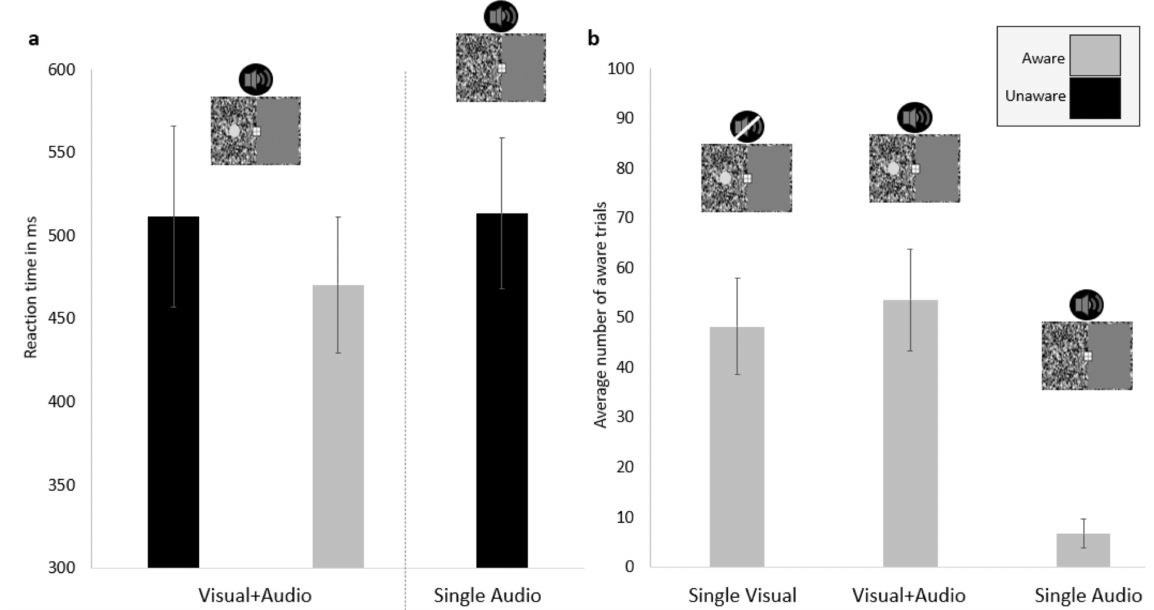
Figure 3. Reaction times of the Visual + Audio and the Single Audio conditions ( a ). The average number of aware trials for the Single Visual, Visual + Audio, and Single Audio conditions ( b ). The error bars represent 95%